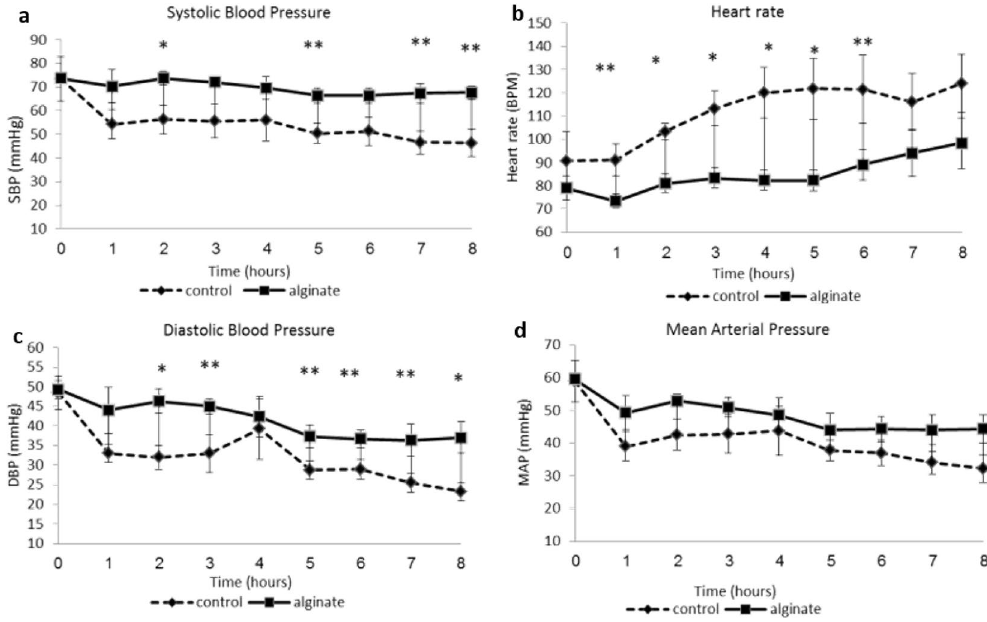
Figure 1. The effect of VLVG alginate on hemodynamic parameters. ( a ) Systolic blood pressure, ( b ) heart rate, ( c ) diastolic blood pressure, ( d ) mean arterial pressure. Data presented as means ± SD , n = 3 (alginate group),